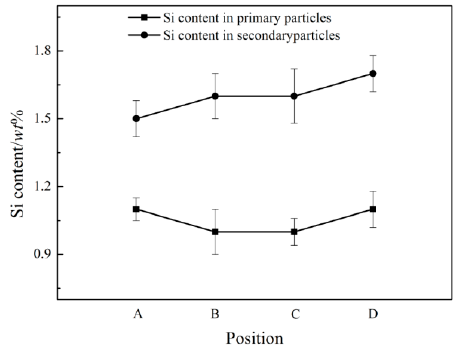
Figure 13. Content of Si in the primary particles and secondary particles in different positions.